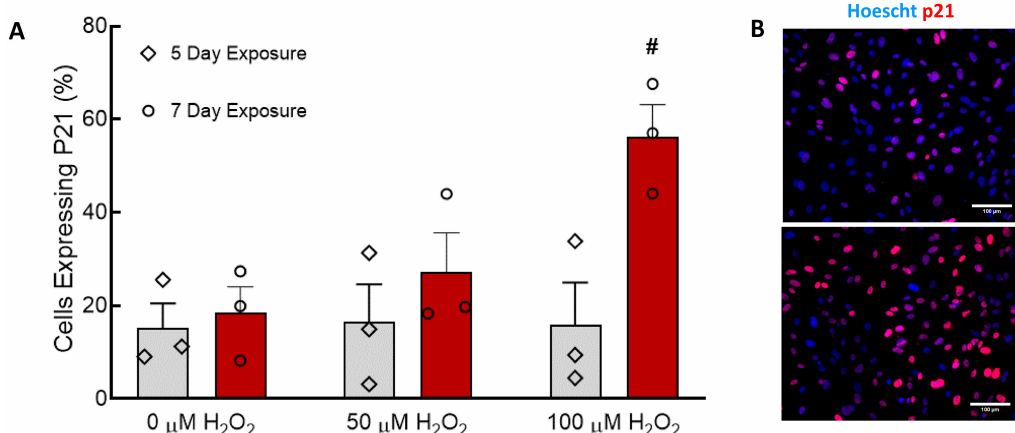
Figure 1. Treatment of cord-blood derived endothelial colony forming cells (CBECFCs) with 100 µ M H 2 O 2 for seven days induced CBECFC senescence. ( A ) The number of senescent (p21 positive) ECFCs was quantified after treatment for five or seven days with H 2 O 2 . H 2 O 2 concentration had a significant e ff ect on p21 expression ( p < 0.05). Treatment with 100 µ M H 2 O 2 for seven days caused a significant increase in senescence compared to the 0 µ M control (# p < 0.01). Bar graphs represent the mean ± SEM, individual points overlaid. N = 3–4. ( B ) Control ECFCs exhibited minimal p21 expression, while ECFCs treated with 100 µ M H 2 O 2 for seven days had high levels of nuclear p21 staining. Scale bars represent 100 µ